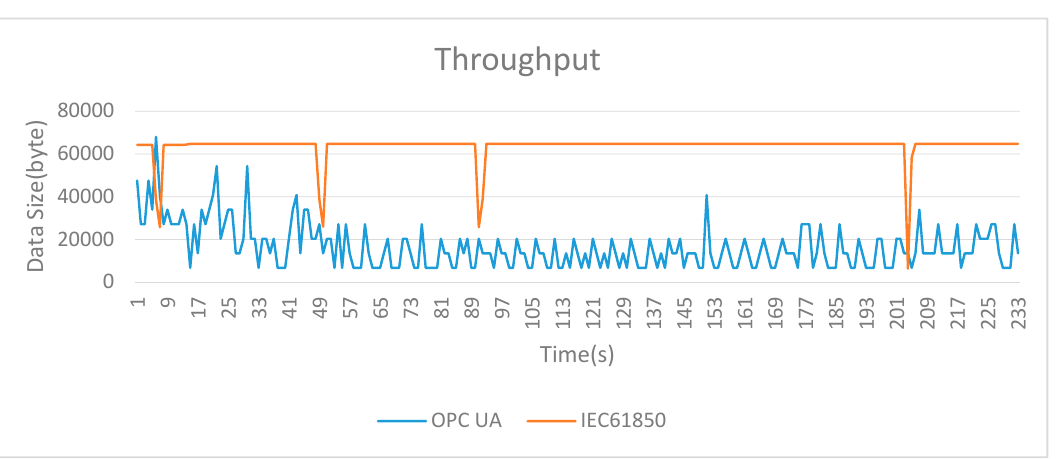
Figure 14. OPC UA and IEC 61850 throughput.